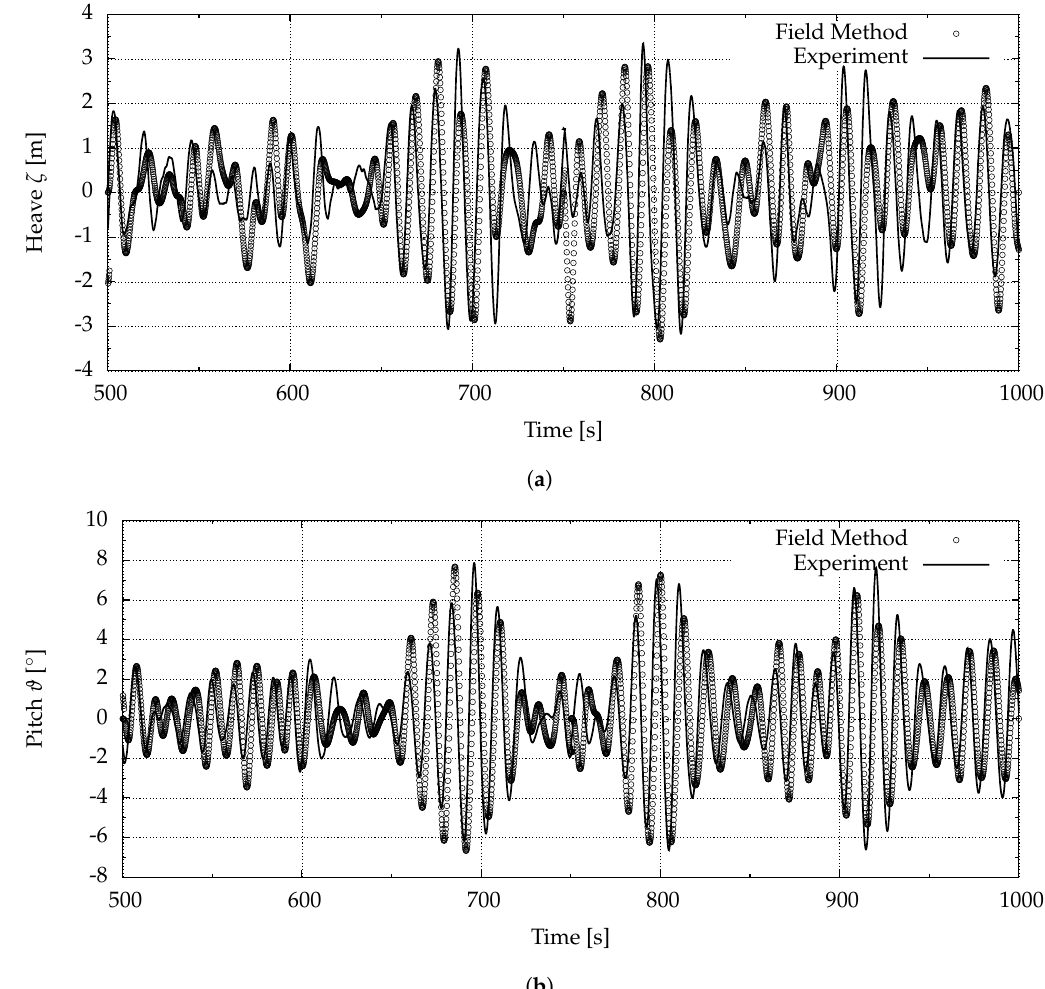
Figure 18. LNG carrier: field method computed and measured time histories of ( a ) heave and ( b ) pitch motions.